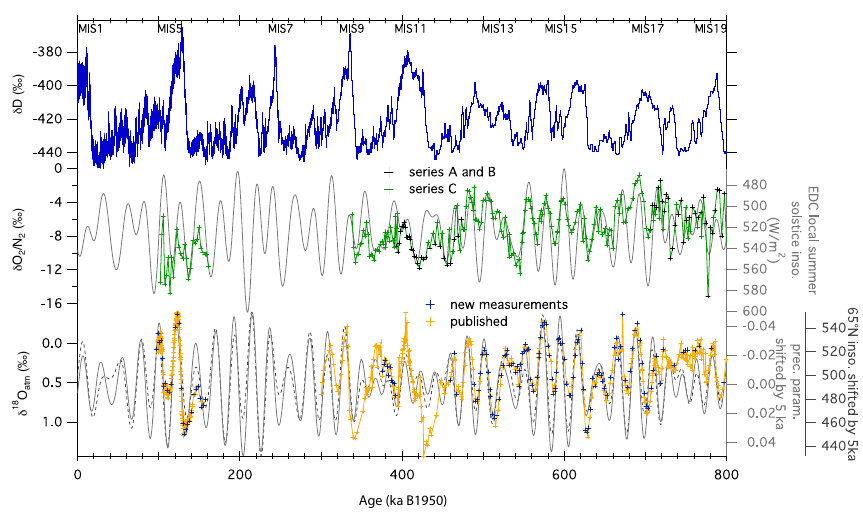
Figure 1. Top: EDC ice core record of water stable isotopes ( δ D, Jouzel et al., 2007). Middle: EDC record of δ O 2 / N 2 (black: Landais et al. (2012), green: this study) and local summer solstice insolation (grey, reversed axis). Bottom: EDC record of δ 18 O atm (reversed vertical scale) (orange: Dreyfus et al. (2007, 2008); Landais et al. (2013), blue: this study), precession parameter (grey, reversed axis) and 65 ◦ N summer solstice insolation (dashed grey) both shifted by 5ka. All EDC records are presented on the AICC2012 chronology (Bazin et al., 2013; Veres et al., 2013). The orbital parameters are calculated using the Laskar et al. (2004) solution, with the Analyseries software (Paillard et al.,